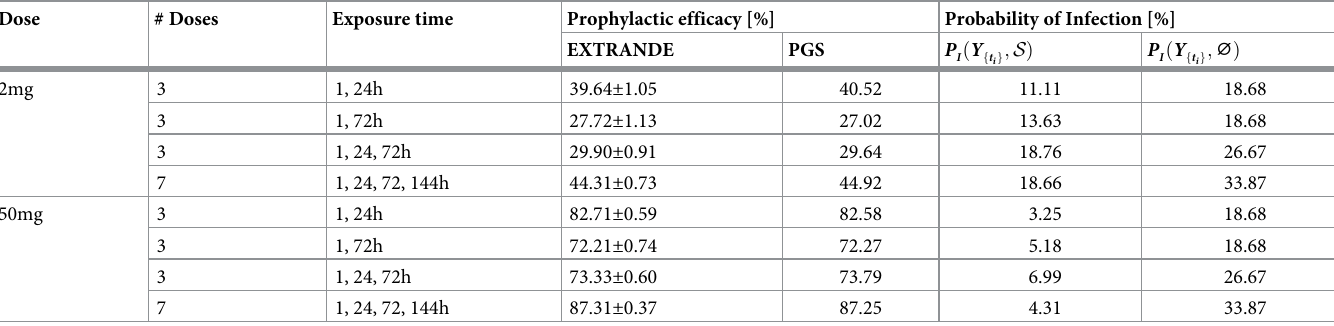
Table 2. Prophylactic efficacy in case of multiple viral